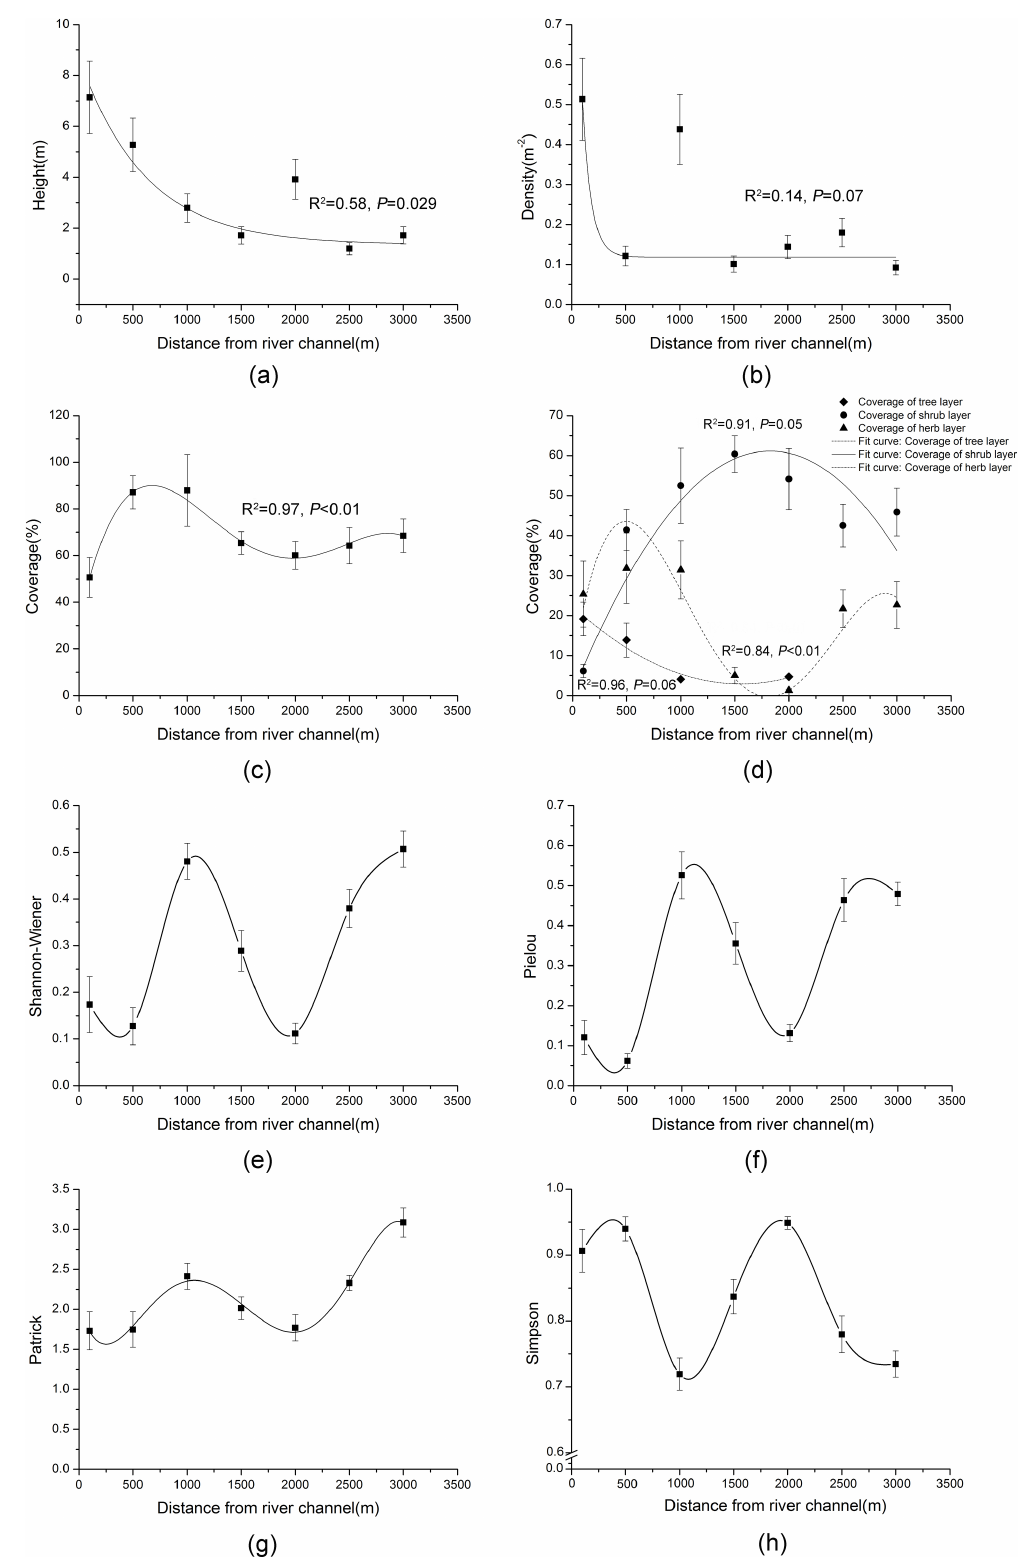
Figure 4. The variation of community structure and diversity with distance from the river